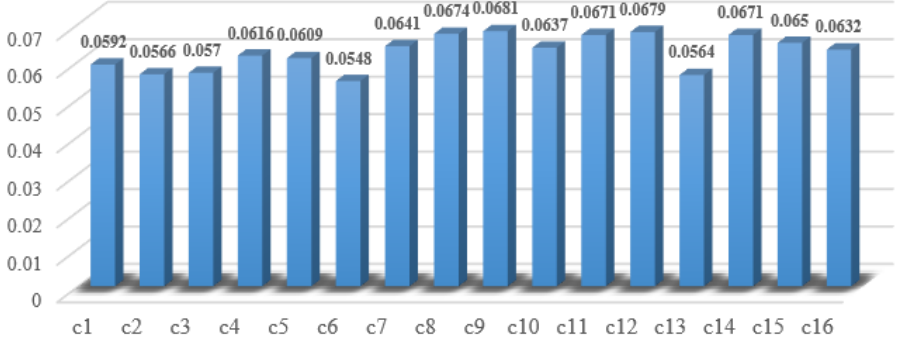
Table 2. The related weight of each criterion. 𝒄 𝟏